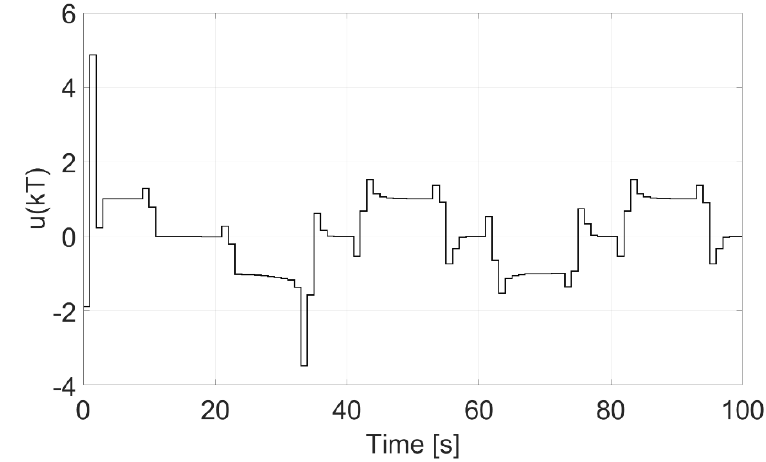
Figure 5. Control signal of the non-switching controller.